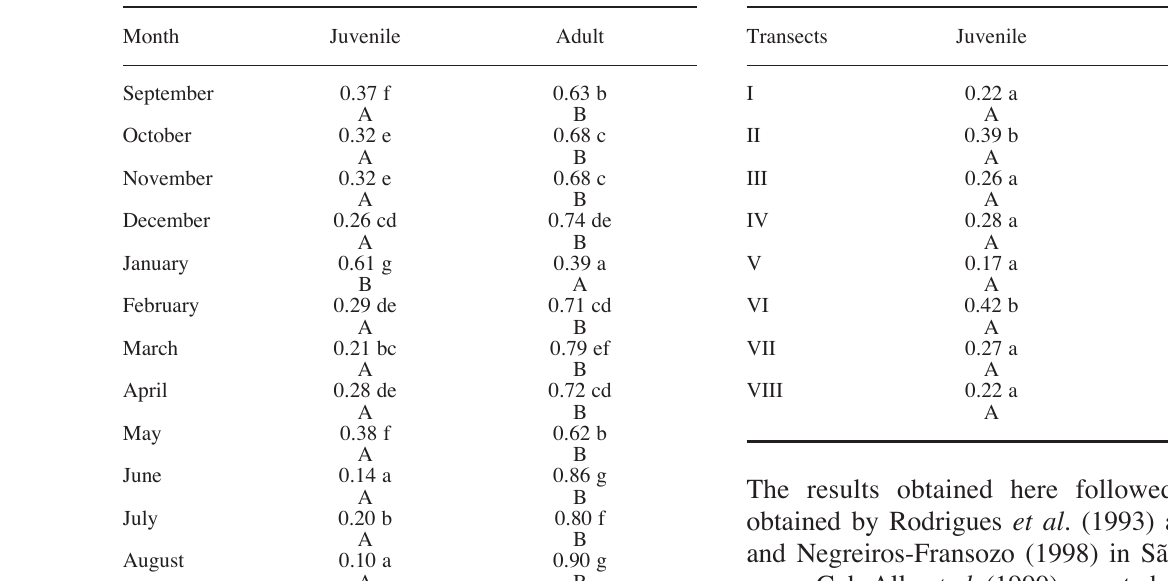
T ABLE 3. – Comparative analysis of the percentages of juveniles and T ABLE 4. – Comparative analysis of the percentages of juveniles and adults monthly sampled between September 1995 and August 1996 adults sampled along the eight transects between September 1995 in the Ubatuba Bay (values with at least one same letter did not dif- and August 1996 in the Ubatuba Bay (values with at least one same fer significantly; lower case letters correspond to comparison of letter did not differ significantly, p < 0.05; lower case letters corre- juveniles and adults over all months sampled; upper case letters cor- spond to comparison of juveniles and adults over all transects; respond to the comparison between juveniles and adults during the upper case letters correspond to the comparison between juveniles same month sampled). and adults between the same